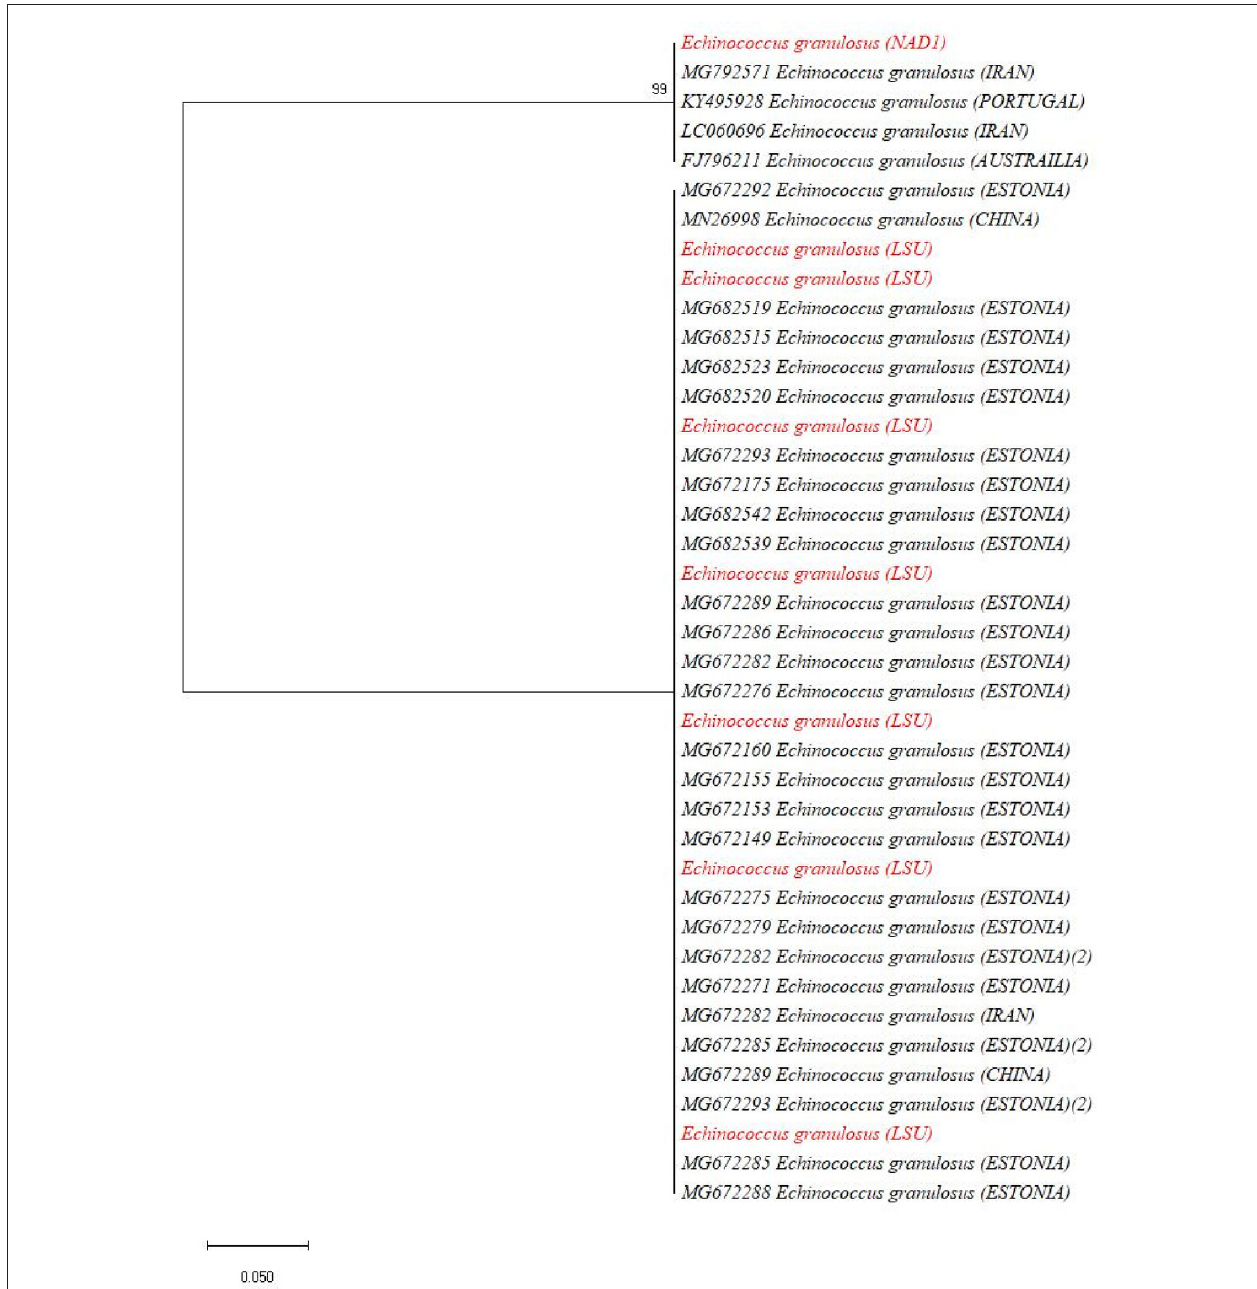
FIGURE 3 | Maximum likelihood phylogenetic tree showing Echinococcus granulosus (G1-G3) genotypes from the livestock population of the Malakand Division, Khyber Pakhtunkhwa, Pakistan, based on nucleotide sequences of the LSU (rrnl) and NAD1 genes.